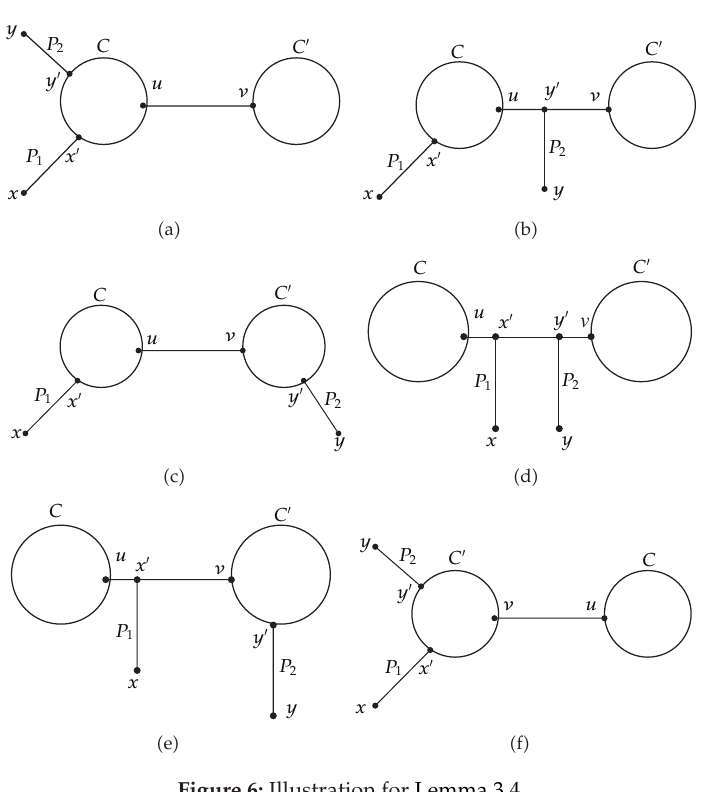
Figure 6: Illustration for Lemma